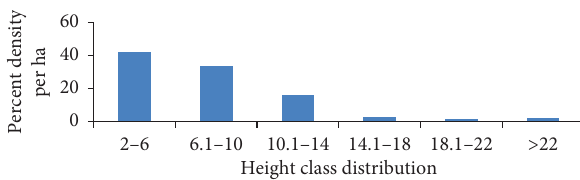
Figure 9: Percent density per hectare of Jib Godo Forest in dif- ferent height